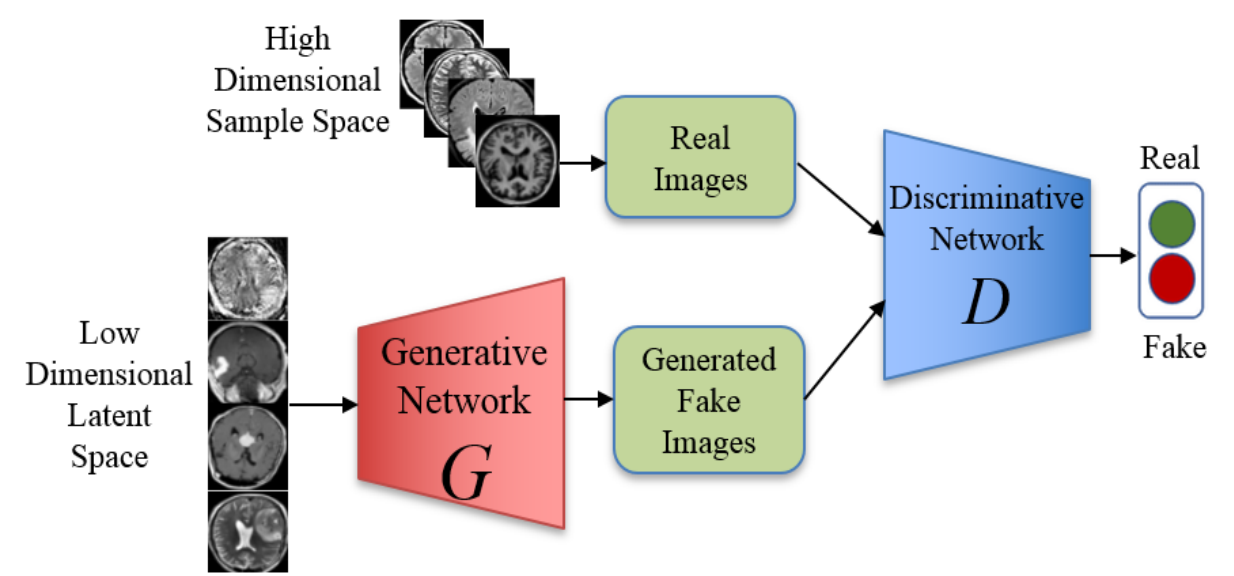
Figure 4. The proposed architecture of the Vanilla GANs to generate MRI images.